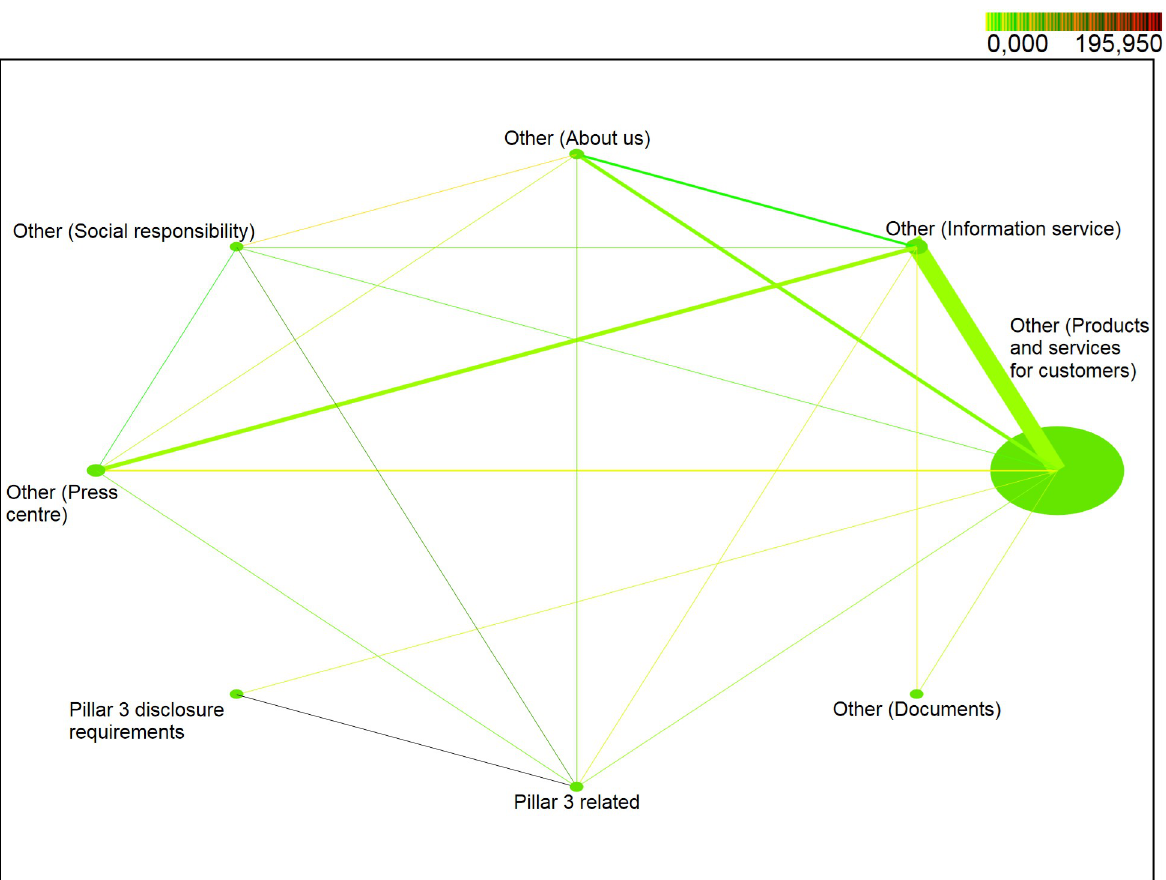
Fig 4. Visualization of frequented web parts of the second quarter of